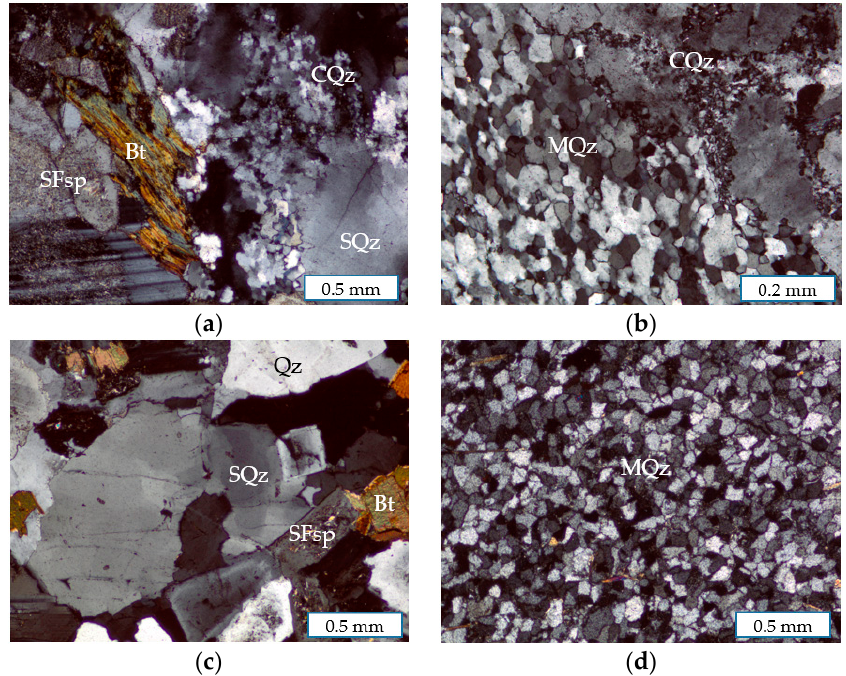
Figure 1. The microphotographs of the analyzed aggregates in cross-polarized light (XPL) ( a , b ) granite G1 aggregate, ( c ) granite G2 aggregate, ( d ) quartzite Q, aggregate; recognized minerals: Qz—quartz, SQz—strained quartz, MQz—microcrystalline quartz, CQz—cryptocrystalline quartz, SFsp—feldspar alteration to sericite, Bt—biotite.